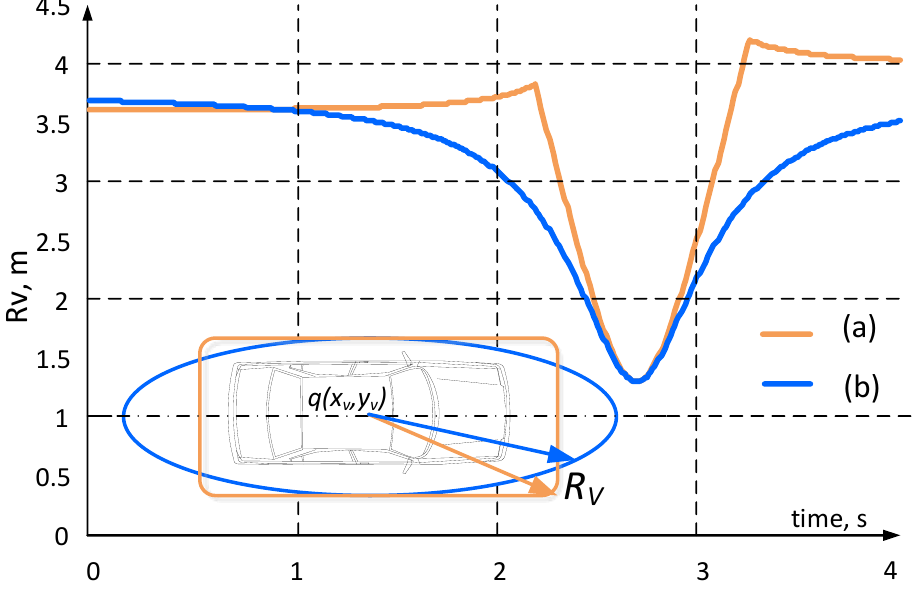
Figure 6. R V parameter change depending on the shape of the safety zone around the vehicle: ( a ) rectangle, ( b ) ellipse.